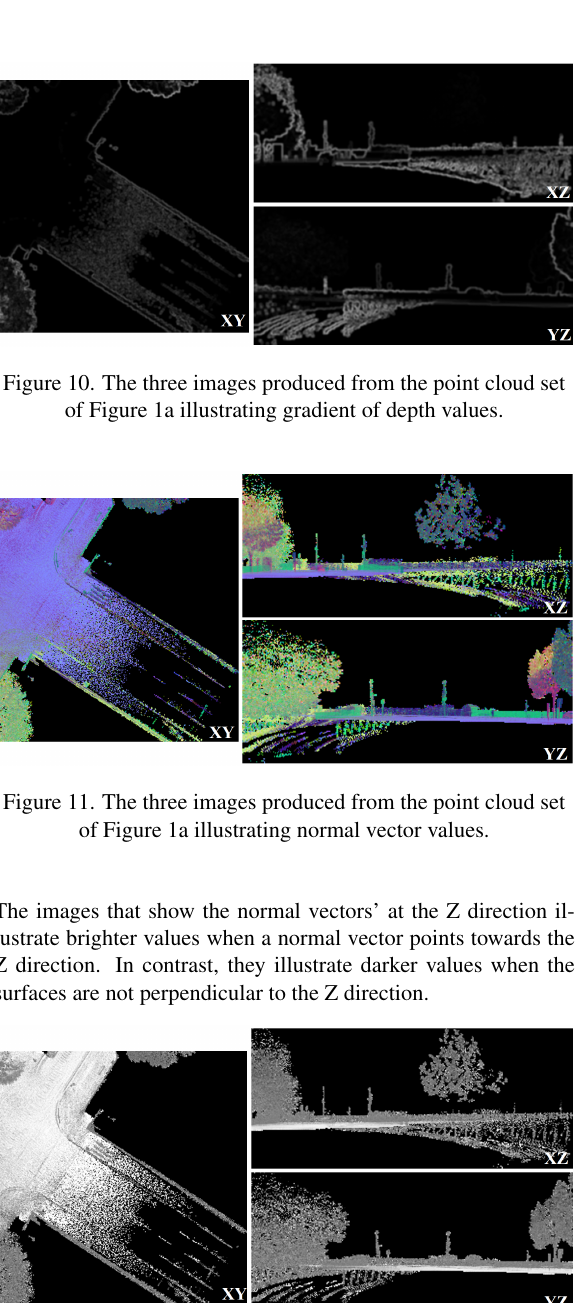
Figure 12. The three images produced from the point cloud set of Figure 1a illustrating the Z values of the normal vectors.